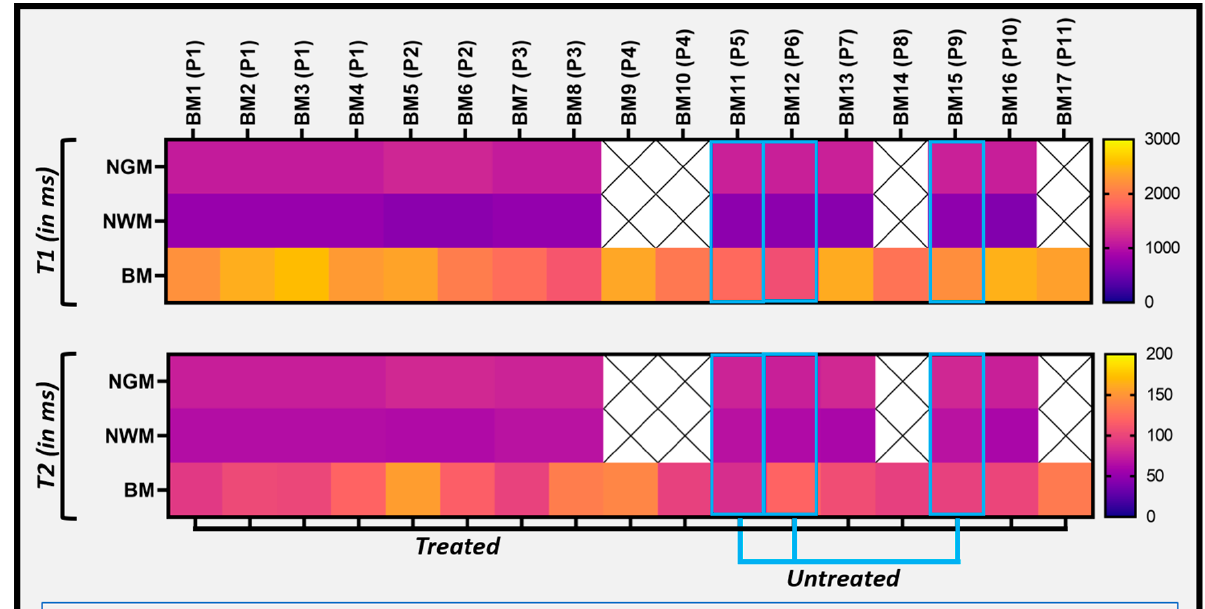
Table 3. T1 and T2 values in patients from the untreated and treated groups.